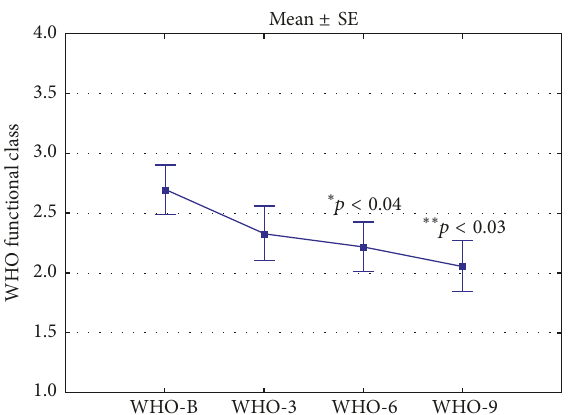
Figure 1: WHO functional class at baseline, 3 months, 6 months, and 9 months after initiation of PAHST.